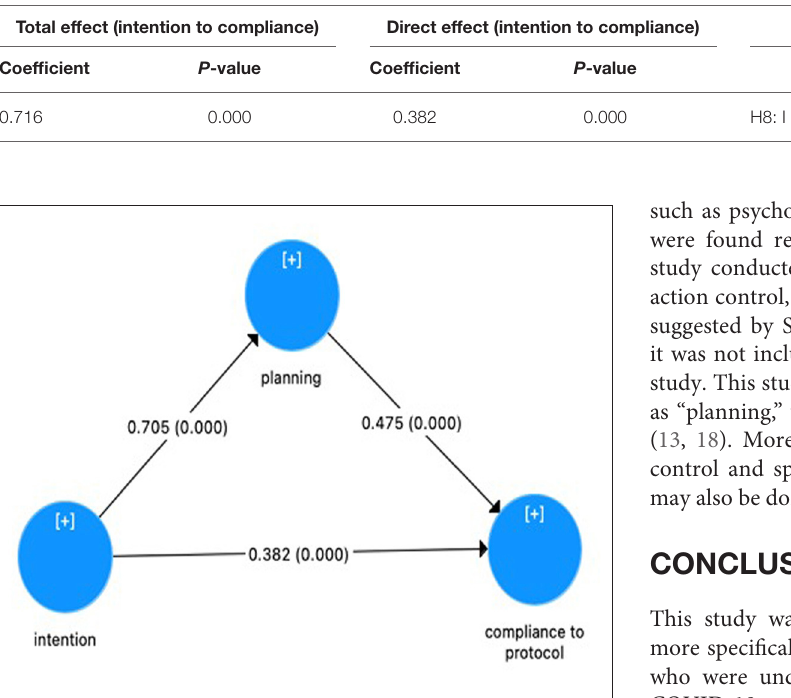
achieved, assessing the situation when the behavior has been performed, and obtaining feedback or appreciation for each behavior that is following the target. The intervention strategies can vary between individuals, depending on each